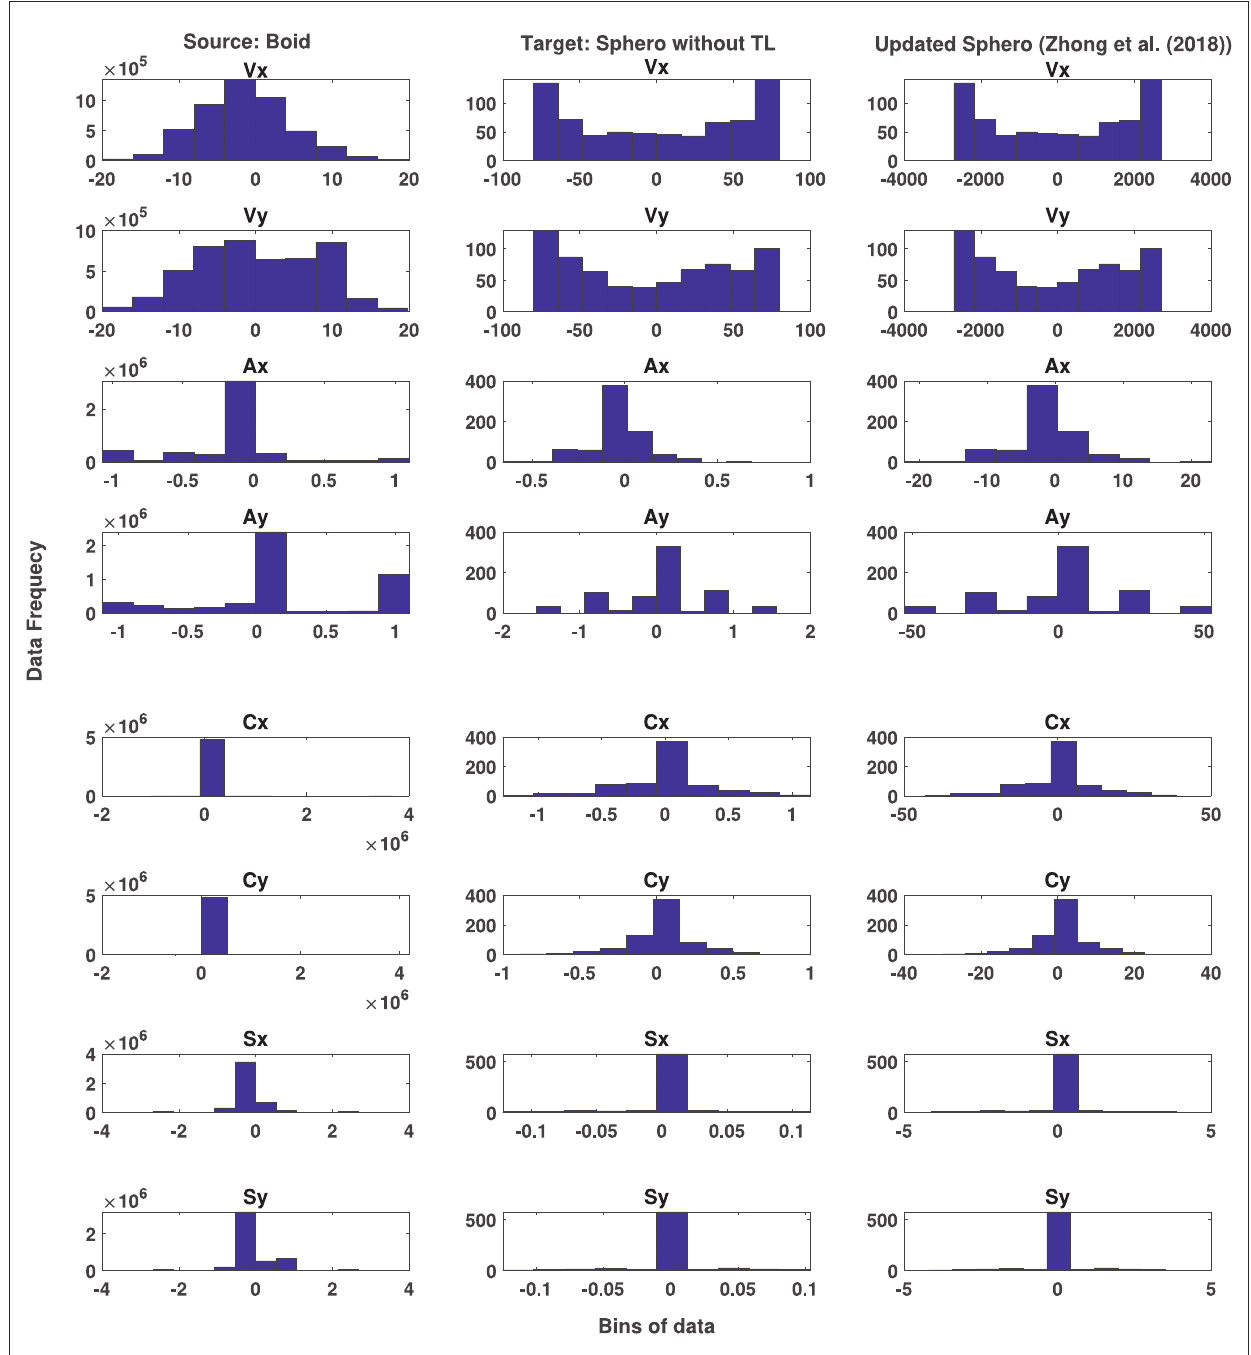
FIGURE6 Distribution of Boid temporal state data (column 1) and original Sphero BOLT temporal state data (column 2) and the effect of transfer learning method proposed by Zhong et al. (2018) (column